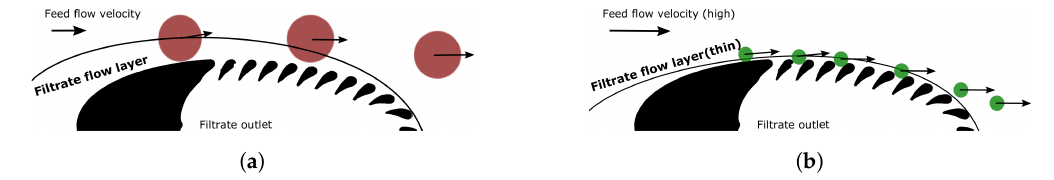
Figure 3. Diagram showing how tunable filtration layers around the trilobite structure are used to control the cutoff size: a particle is directed downstream to a retentate outlet by texternal flow when its center is outside of the filtrate layer. ( a ) Filtering of large spheres by a thick filtration layer and ( b ) filtration of small spheres by a thin filtration layer are shown.